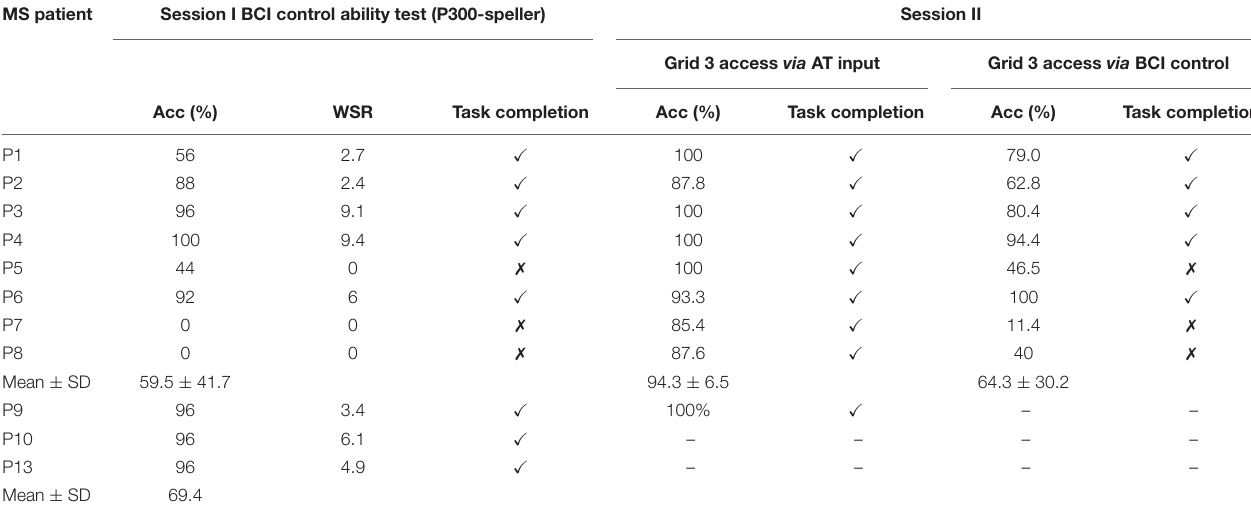
TABLE 2 | Performance data in sessions I and II. MS patient Session I BCI control ability test (P300-speller) Session II